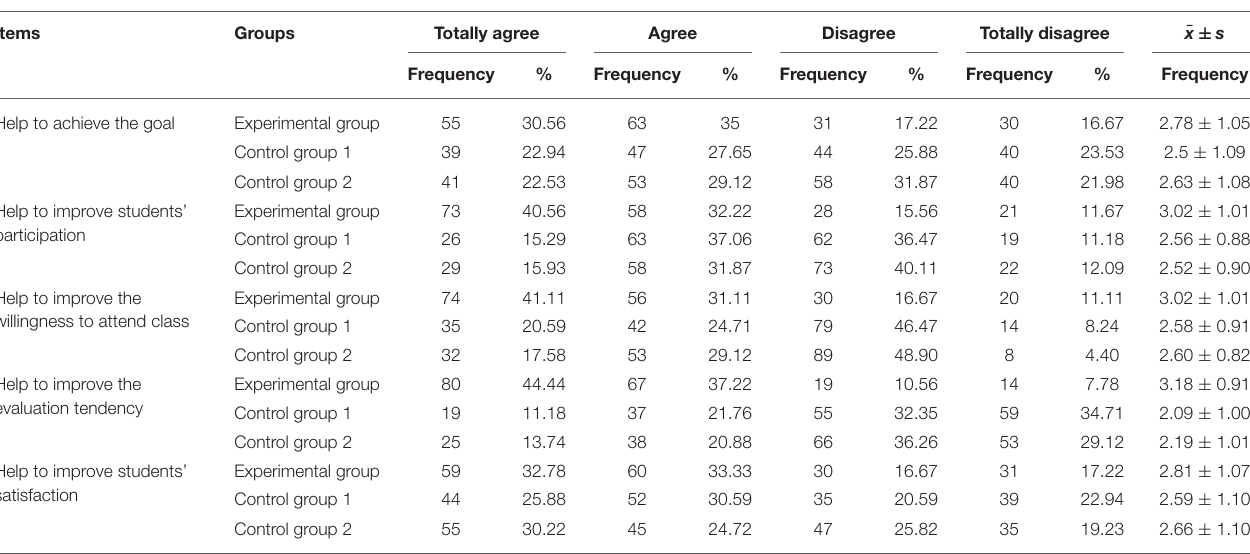
TABLE 4 | Overall situation of the questionnaire